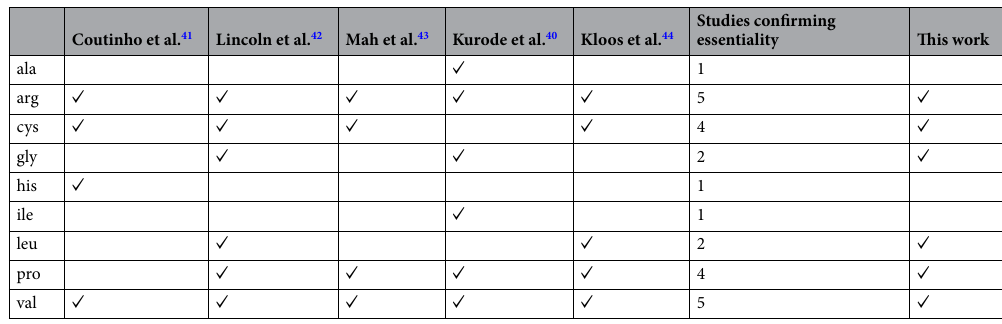
Table 4. Essential AA. This table shows the essential AA for the WT in the in vitro experiments based on the AUC (AUC = 8–15; compare Table 3) and compares it to earlier